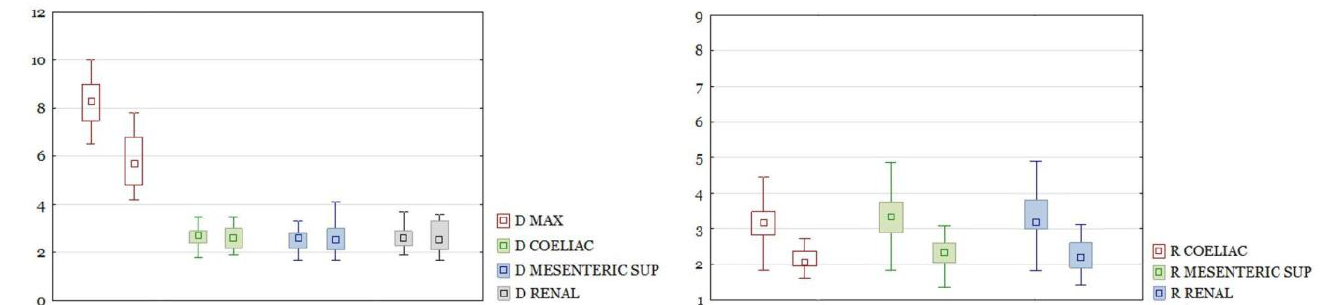
Figure 5. On the left, a comparison of diameters of the aorta between ruptured and unruptured aneurysms with the neck segment absent. Diameters in cm. Boxplots are shown in pairs. The left one is diameter for ruptured, the right one is diameter for unruptured aneurysms. Only D MAX difference is significant with p < 0.05. On the right, a comparison of ratios between ruptured and unruptured aneurysms. Boxplots are shown in pairs. The left one is ratio for ruptured, the right one is ratio for unruptured aneurysms. All differences significant at p < 0.05.